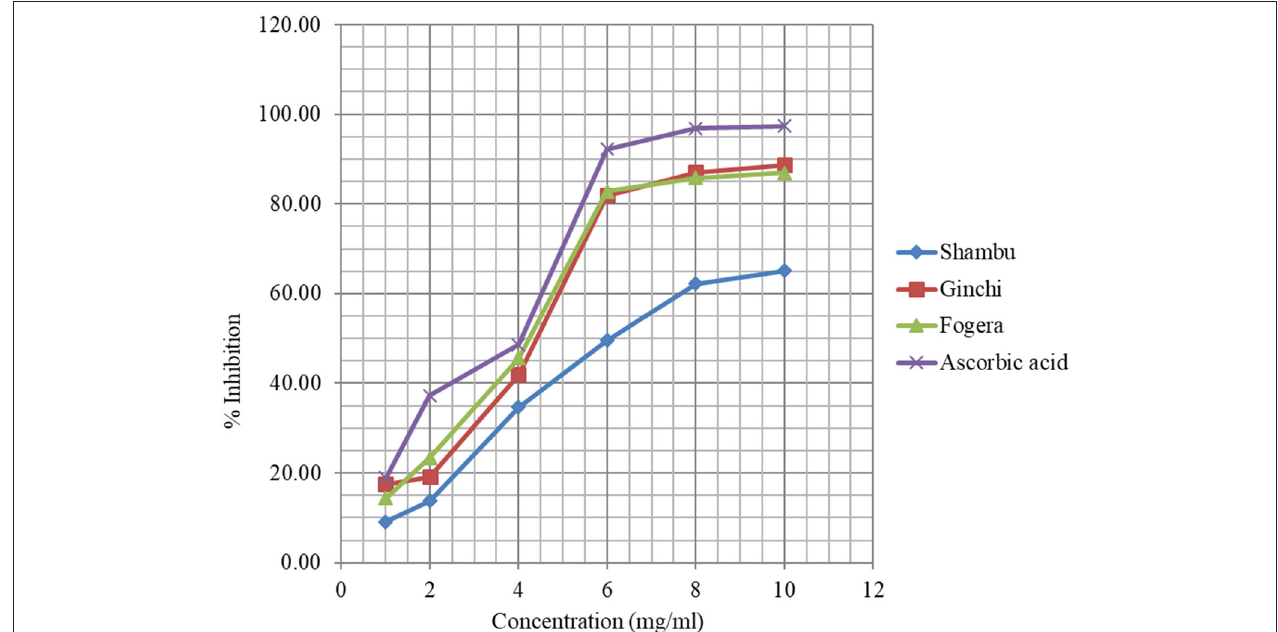
FIGURE 1 | Free radical scavenging of methanolic extracts of three niger seed varieties and the control.